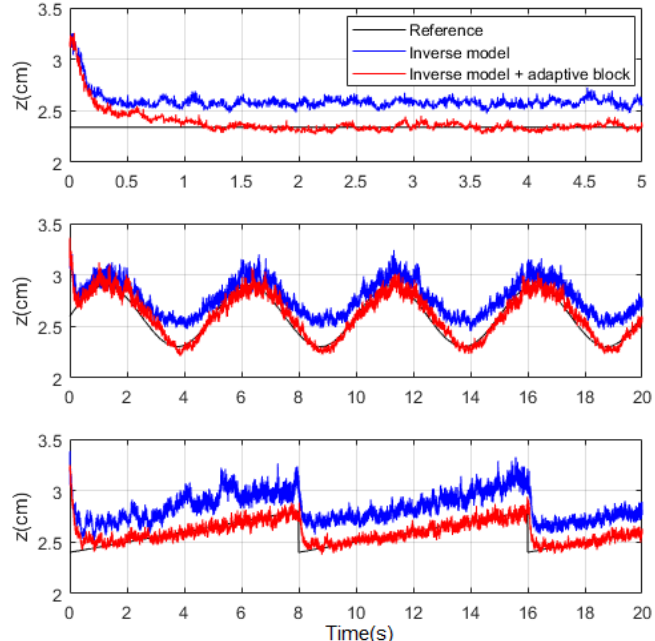
Figure 18. System response with the inverse model